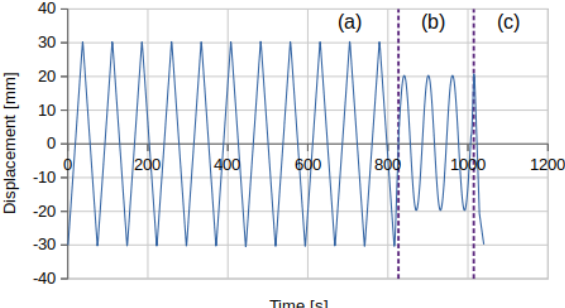
Figure 3. Complete time-displacement progress of pre-conditioning sequence ( a ), friction recording sequence ( b ) and return to initial position ( c ).